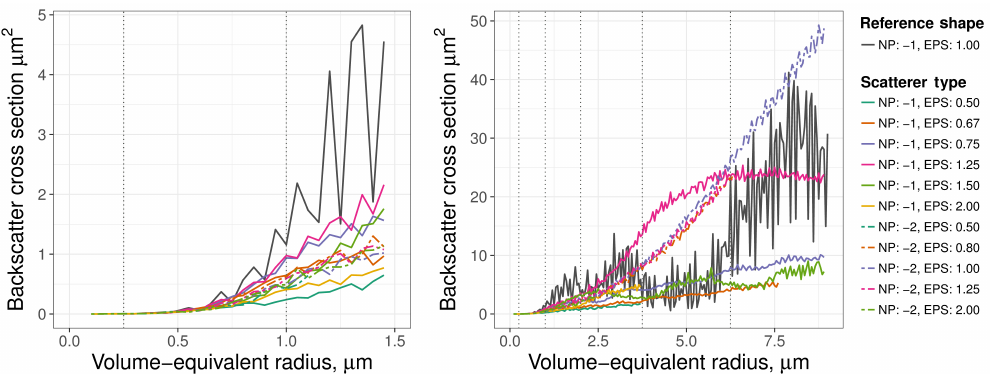
Figure 8. The same as Fig. 7 but for the backscatter cross section. A high particle shape sensitivity of the backscatter cross section can be observed which becomes pronounced for particles with radii greater than 0 . 5 λ . While the backscatter cross section of ellipsoids increases only weakly with particle size, the backscatter cross section of cylinders increases near exponentially with size. The backscatter cross section spectrum of spheres has larger-scale fluctuations which are due to interference effects. For particle size classes 4 and 5, the backscatter cross section of spheres is between the values of ellipsoids and cylinders which indicates that a spherical shape is a valid representative for large volcanic ash size classes